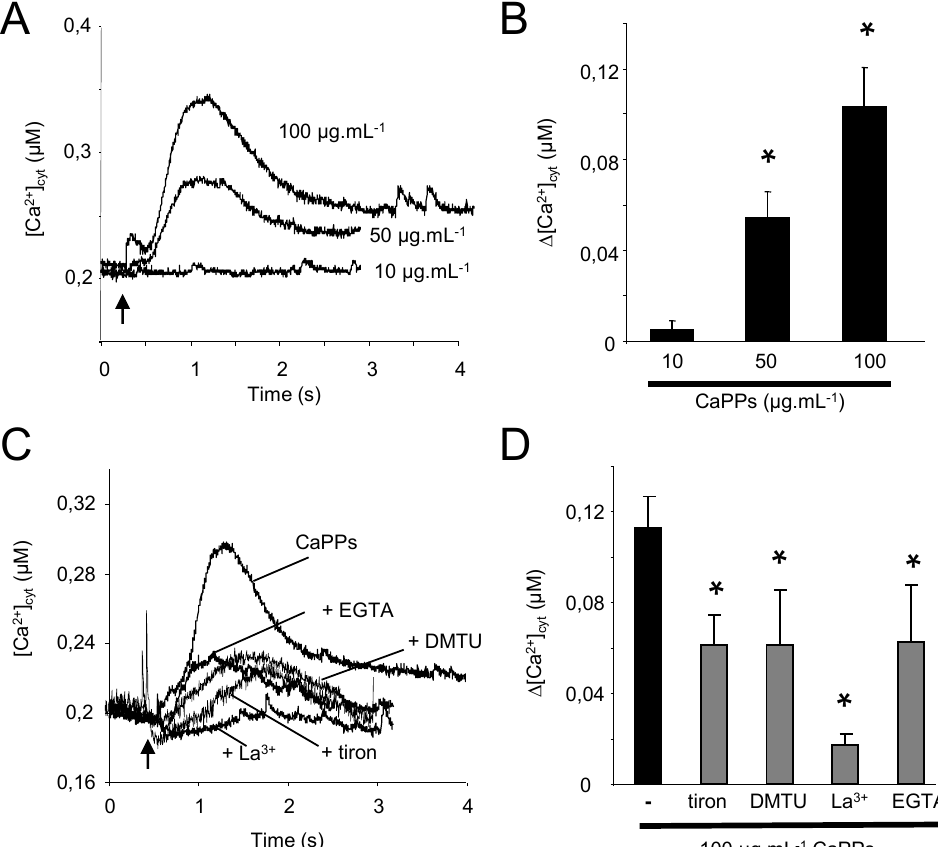
Figure 2. CaPP-induced variations of cytosolic Ca 2 + in BY-2 cells. ( A ). A typical [Ca 2 + ] cyt variations of aequorin expressing BY-2 cells in response to various concentrations of CaPPs. ( B ). Mean values of maximal [Ca 2 + ] cyt increase in response to various concentrations of CaPPs. * Significantly di ff